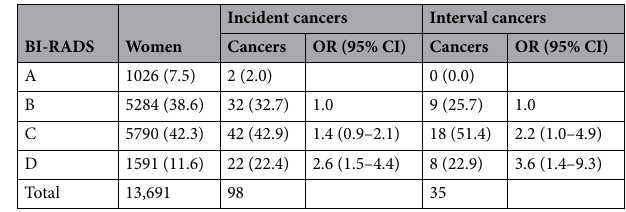
Table 2. Risk of incident and interval cancers according to the breast density as evaluated by DSM in RETomo and Florence studies. Values are n (%) unless otherwise stated.